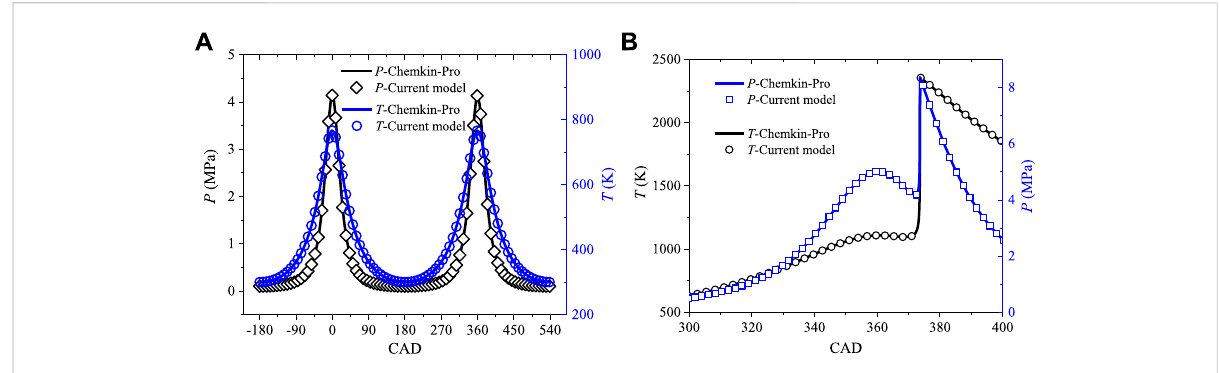
FIGURE 3 Cylinder pressure and temperature traces in pure compression/expansion processes without ignition (A) and with ignition (B) from the current model and Chemkin-Pro.